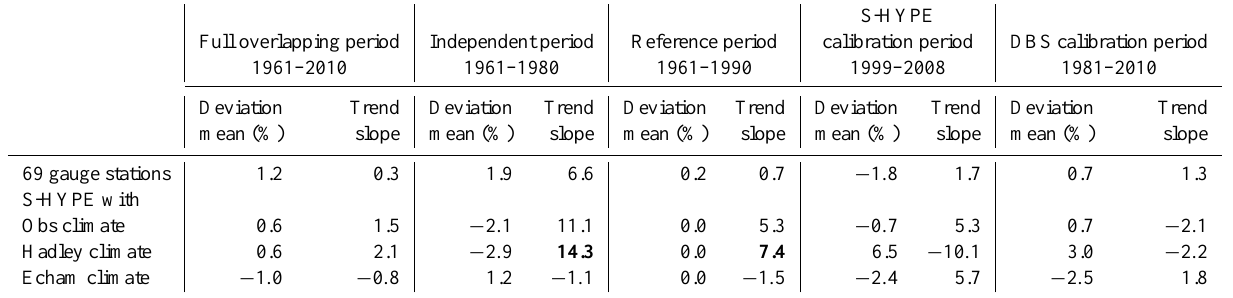
Table 1. Deviation (%) in relation to the mean for the reference period (1961–1990) and trends (slope in percent per decade) for annual anomalies in high flows at the 69 river gauges, using observed discharge from gauges and S-HYPE modeled discharge, the latter with Hadley or Echam forcing from observed climate and climate projections. Bold numbers indicate a significance level of P = 0 . 05 (Yevjevich,